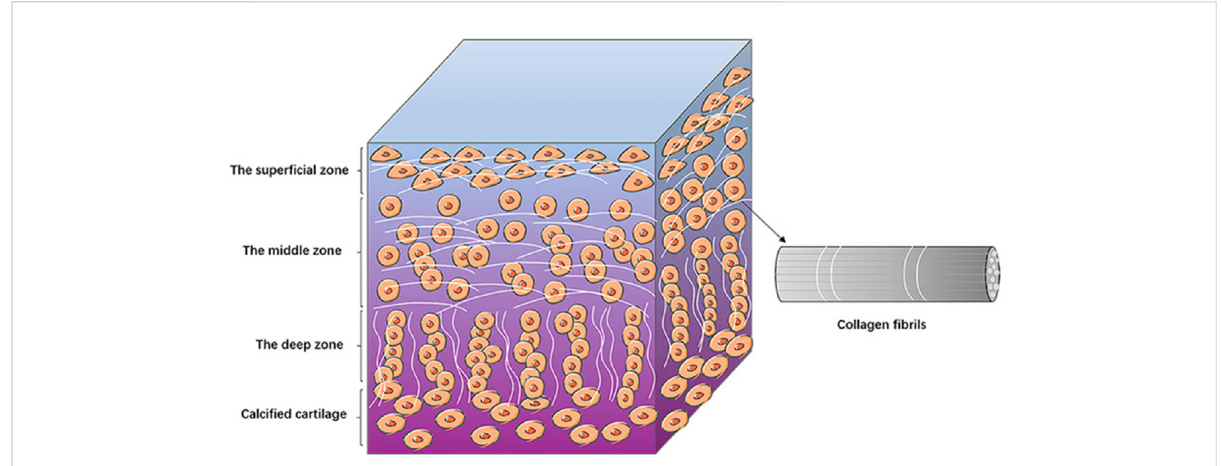
FIGURE 1 The structure of articular cartilage. The diagram shows the basic structures of the surface, middle and deep zones of the articular cartilage. Chondrocytes are arranged differently indifferentzones. The collagen fi bersare linedup with chondrocytes (Jiangetal., 2022).Copyright2022, Am J Transl